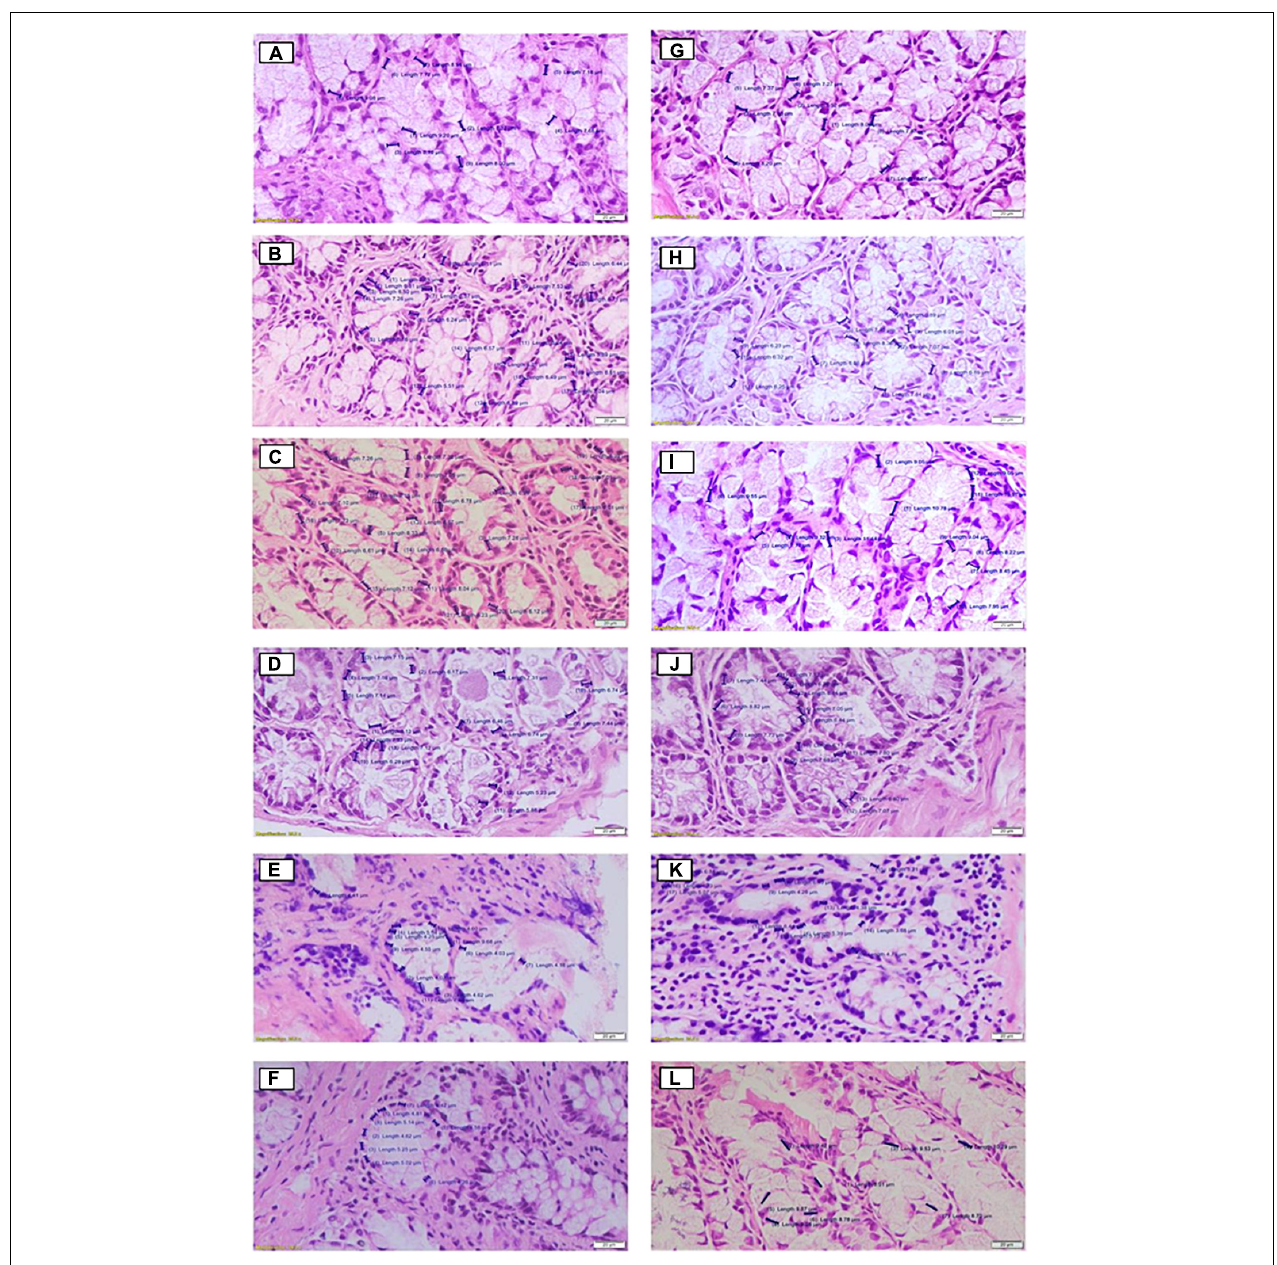
FIGURE 2 | Histological effects of the diets on cell nucleus size in the cecum (A–F) and proximal colon (G–L) of rats fed for 35 days with different doses of Agave salmiana fructans, panels (A,G) are the control of the cecum and proximal colon, respectively, and panels (B,H) are the doses of 5%, with panels (C,I) of 10%, panels (D,J) of 12.5%, panels (E,K) of 15%, and panels (F,L) of